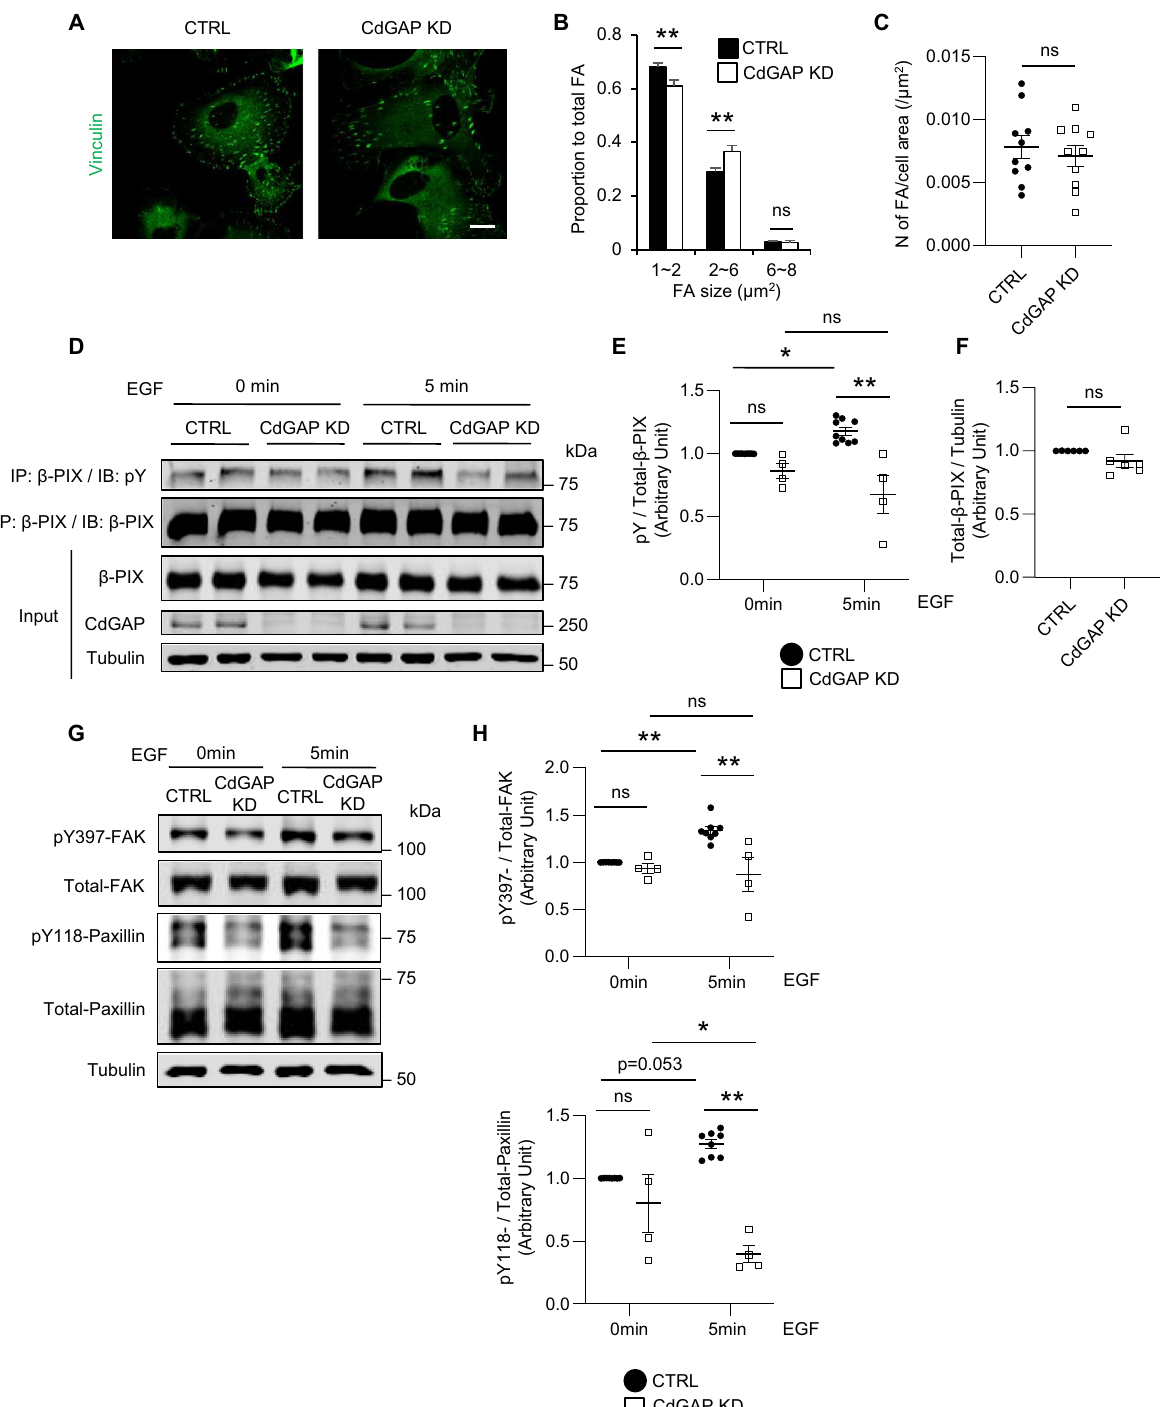
Figure 5. CdGAP modulates focal adhesions in podocytes. ( A ) Representative images of the immunofluorescence staining for vinculin (green) of differentiated CdGAP KD and control (CTRL) podocytes. ( B ) The proportion of small (< 2 µm 2 ), medium (2–6 µm 2 ), and large (< 6 µm 2 ) focal adhesions (FA) to total FA is shown. ( C ) The number of FA per cell area. ( D ) Differentiated CdGAP KD and CTRL podocytes were stimulated with EGF (100 ng/ml) and lysed at the indicated times. Lysates were subjected to co-immunoprecipitation with anti-β-PIX antibody, followed by immunoblotting for phosphotyrosine (pY). Representative immunoblots for pY, β-PIX, CdGAP, and tubulin are shown. ( E ) Densitometric quantification of pY normalized to total expression of β-PIX in ( D ). ( F ) Densitometric quantification of total expression of β-PIX normalized to tubulin in ( D ). ( G ) Representative immunoblots for pY- and total FAK and paxillin using differentiated CdGAP KD and CTRL podocytes treated with EGF (100 ng/ml). ( H ) Densitometric quantification of pY397-FAK and pY118-paxillin normalized to total FAK and paxillin, respectively, in ( G ). n = 16–20 ( B ); 10 ( C ); 4–9 ( E ); 6 ( F ): 4–8 ( H ). ns, not significant. Statistically significant differences (* P < 0.05, ** P < 0.01), assessed by either the Student’s t-test ( C,F ) or ANOVA with the Tukey–Kramer test ( E,H ), are indicated. Bar: 20 µm ( A